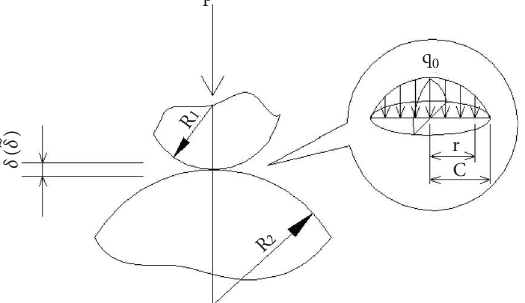
Figure 9: Contact between